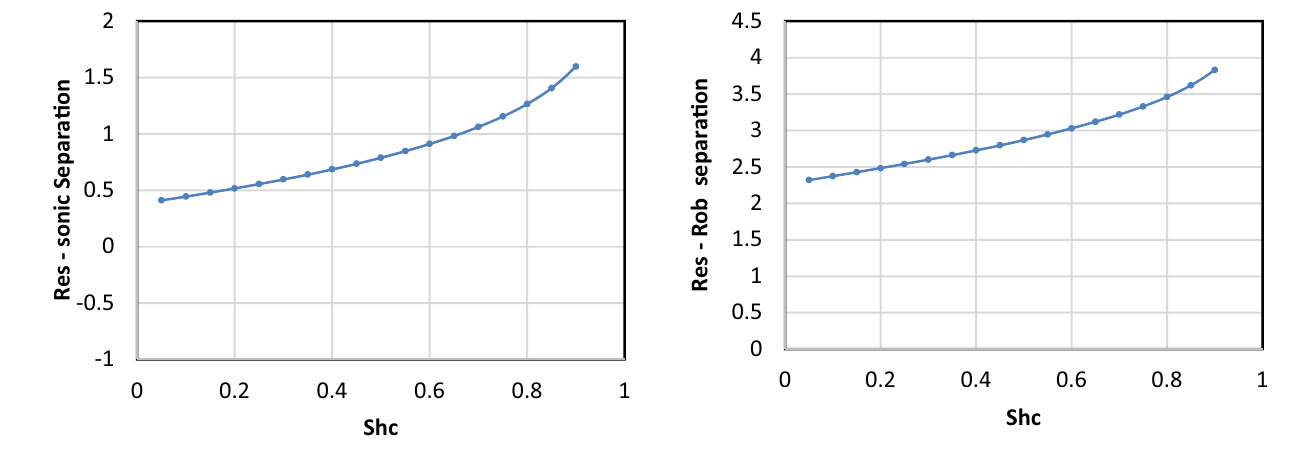
Fig. 19 S hc versus separation for